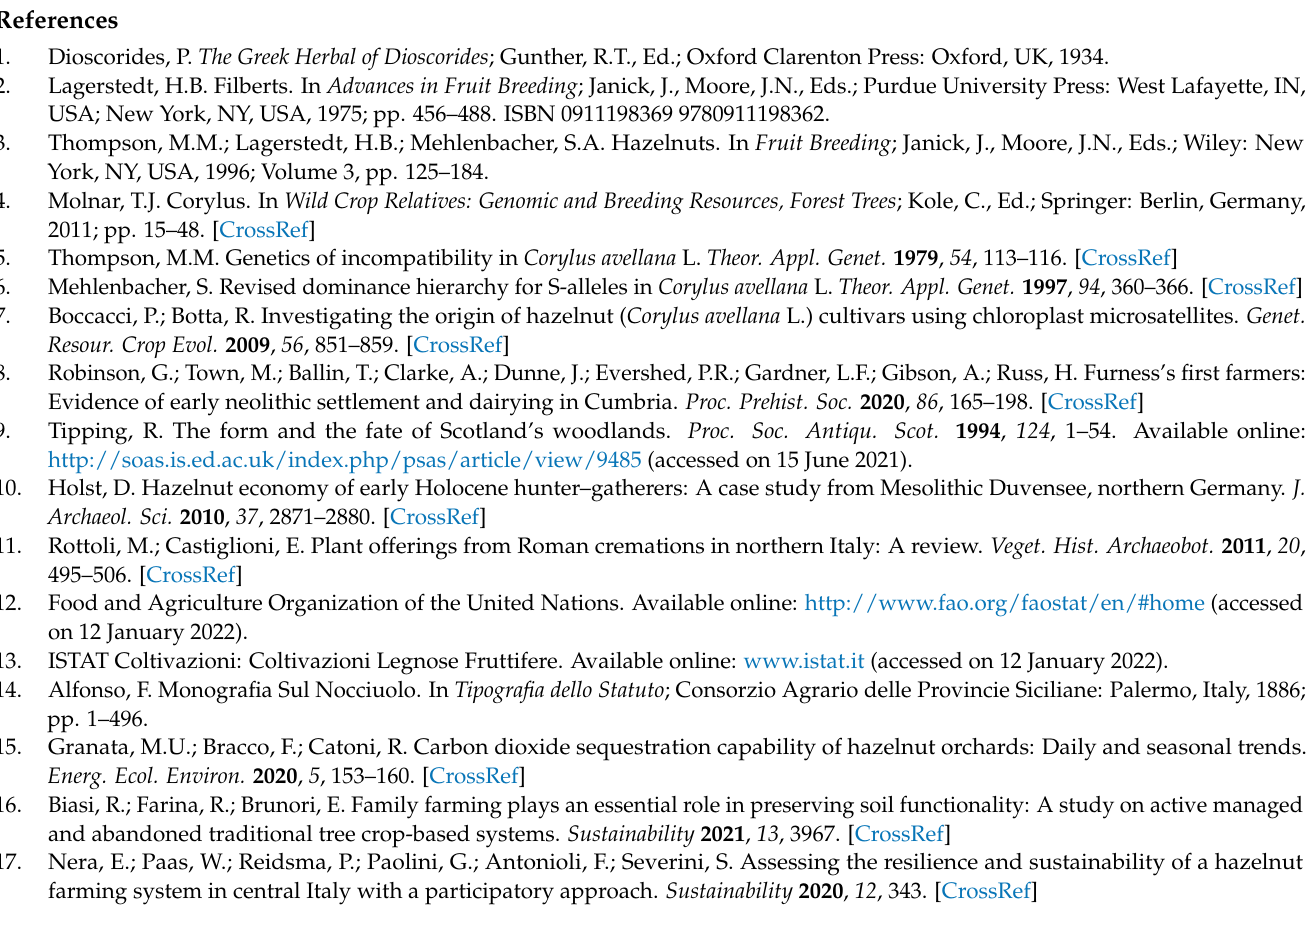
Table S9: 75 hazelnut accessions of Corylus avellana L. sampled in different field germplasm collections of the Nebrodi Mountains (Sicily, Italy). Table S10: List of descriptors evaluated in 30 nuts for each Sicilian genotypes sampled in the Nebrodi Mountains. Table S11: Summary of the 9 SSR markers, primer multiplex, and co-loading sets used in the